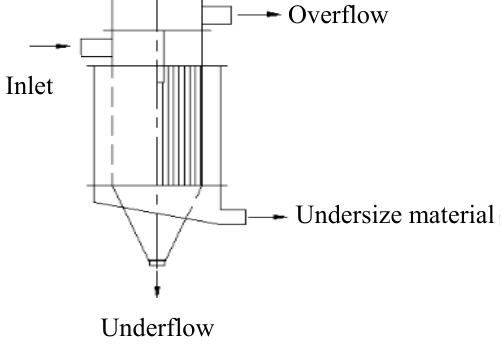
Figure 3. Diagram of the hydrocyclone with screen.